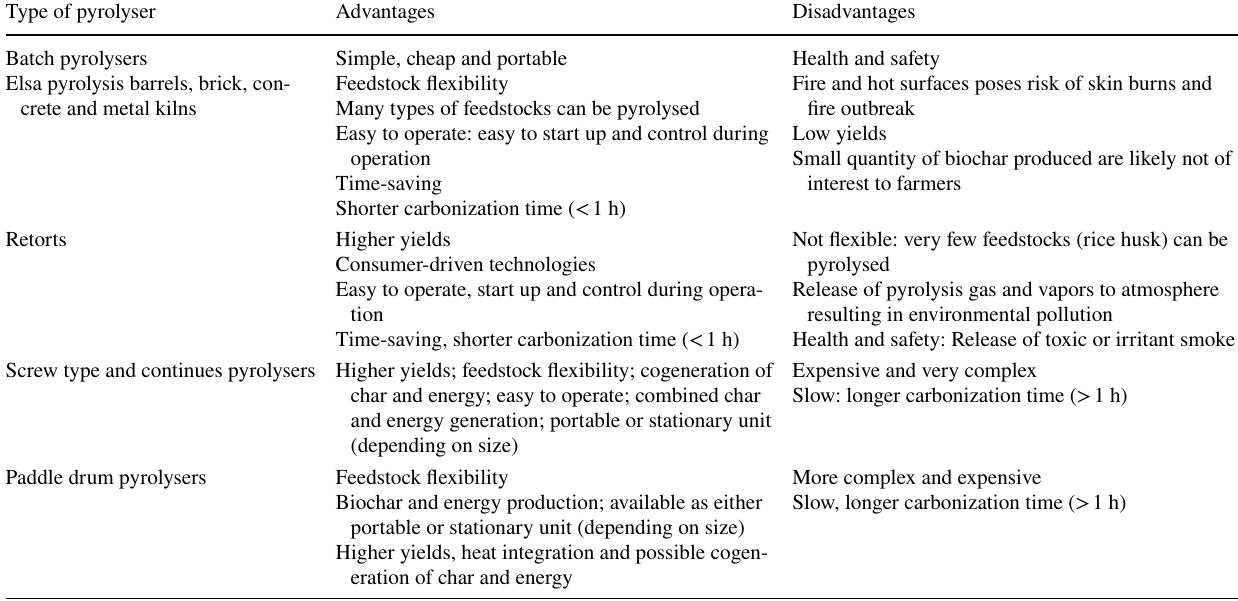
Table 1 Comparison of different types of pyrolysers for biochar production. Source: Hussein et al. (2015); Homagain et al. (2016) Type of pyrolyser